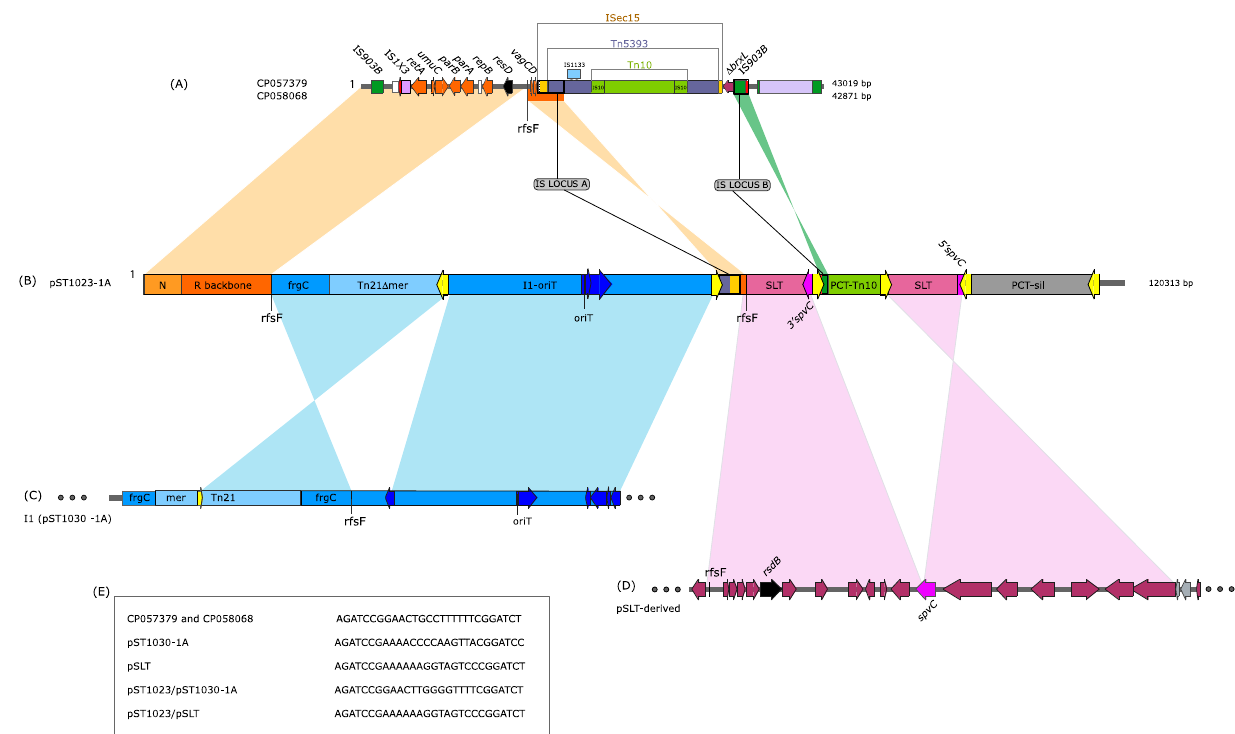
Figure 2. The mosaic plasmid pST1023. Shaded regions, with nucleotide identity ≥ 99%, are marked by colours. ( A ) IncR plasmids sharing the N region, R backbone, loci A and B. ( B ) Linear map of pST1023. The different regions that constitute the mosaic pST1023 are shown with coloured boxes. IS 26 elements are in yellow. ( C ) Regions of IncI1 plasmids (such as pST1030-1A) shared with pST1023. ( D ) Regions of pSLT-derived plasmids shared with pST1023. ( E ) Sequences of rfsF sites are reported.